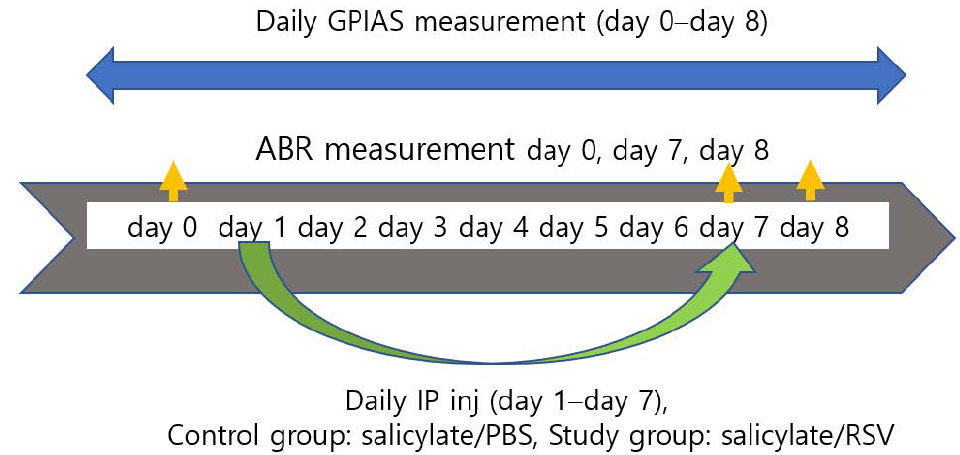
Figure 8. Schematic diagram of in vivo experimental procedure for investigating the tinnitus-attenuating effect of resveratrol in Sprague Dawley (SD) rats. Drugs were administered from day 1 to day 7 in the control and study groups (salicylate, RSV (resveratrol), and PBS (phosphate-buffered saline)). Gap-prepulse inhibition of acoustic startle reflex (GPIAS) was measured from day 1 to 8. Auditory brainstem response (ABR) thresholds were evaluated on day 0 as well as on days 7 and 8.